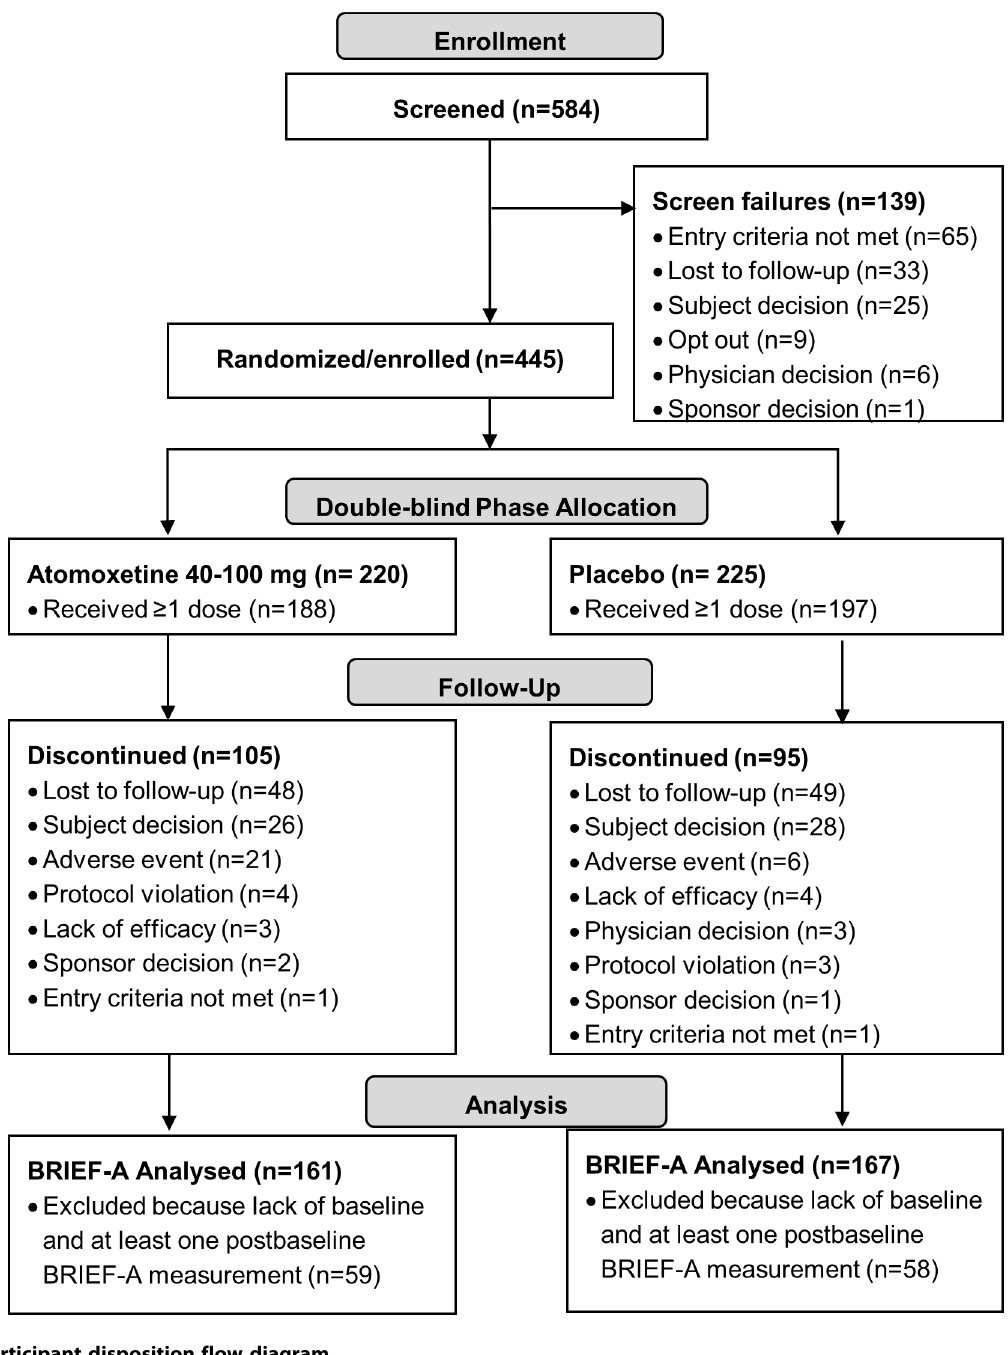
Figure 1. Participant disposition flow diagram.